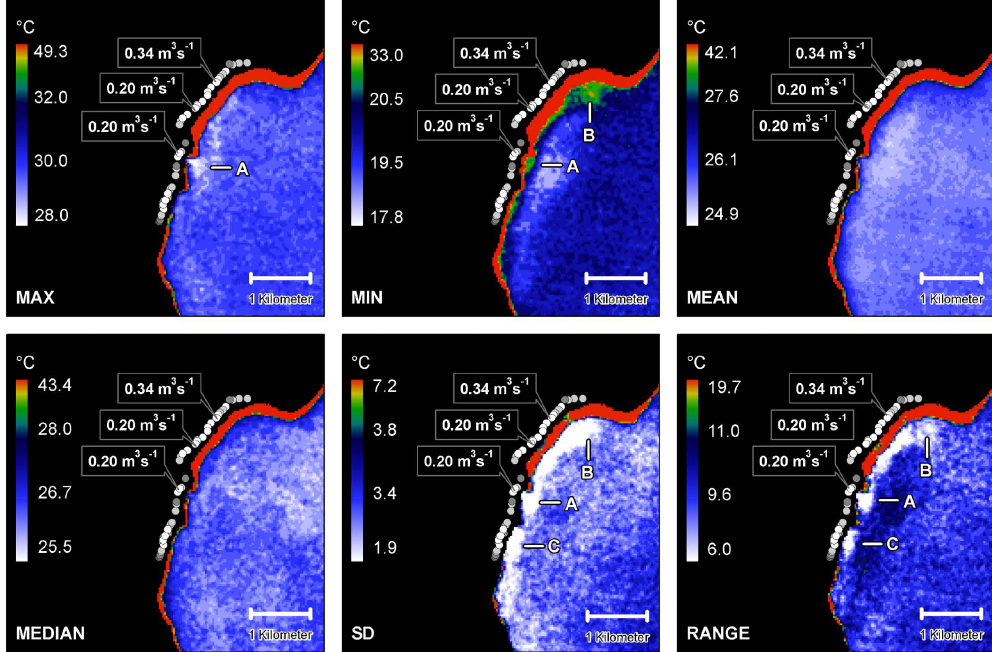
Figure 7. Intercomparison of statistical measures on a per-pixel basis of an SST data series and in situ measured spring discharge volumes from March 2008 (white circles ≥ 0.1m 3 s − 1 ; light grey circles 0.01– < 0.1m 3 s − 1 ; dark grey circles < 0.01m 3 s − 1 ) , showing the example of a major spring site (Ein Feshkha). The tags indicate the discharge volume and the location of the three largest springs at this site; corner coordinates (Lat, Lon) of subsets UL 31.72,35.41 LR 31.66,35.50. Note that the measured spring-discharge locations observed by the IHS are spatially shifted by 200m perpendicular to the coast to account for the shoreline retreat between the investigation period (2000–2002) and the time of measurement